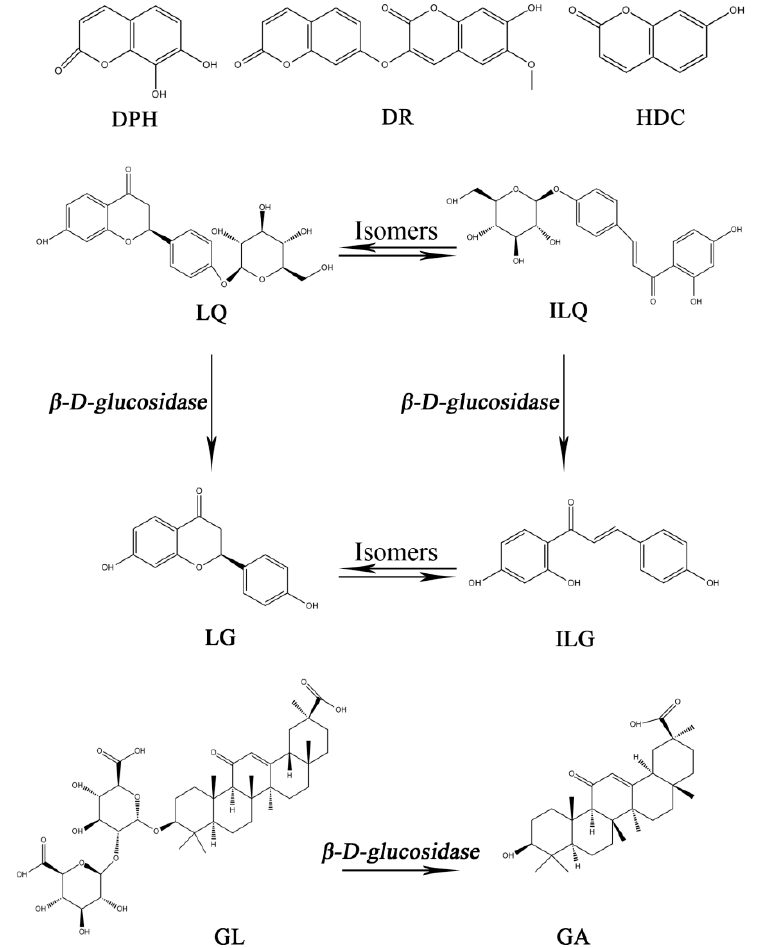
Figure 3. The chemical structures of nine components in Zushima and Gancao and the relationship between them are annotated in the figure as appropriate. Abbreviation notes: DPH: daphnetin; DR: daphnoretin; HDC: 7-hydroxycoumarin; LQ: liquiritin; ILQ: isoliquiritin; LG: liquiritigenin; ILG: isoliquiritigenin; GL: glycyrrhizin; GA: glycyrrhetinic acid.